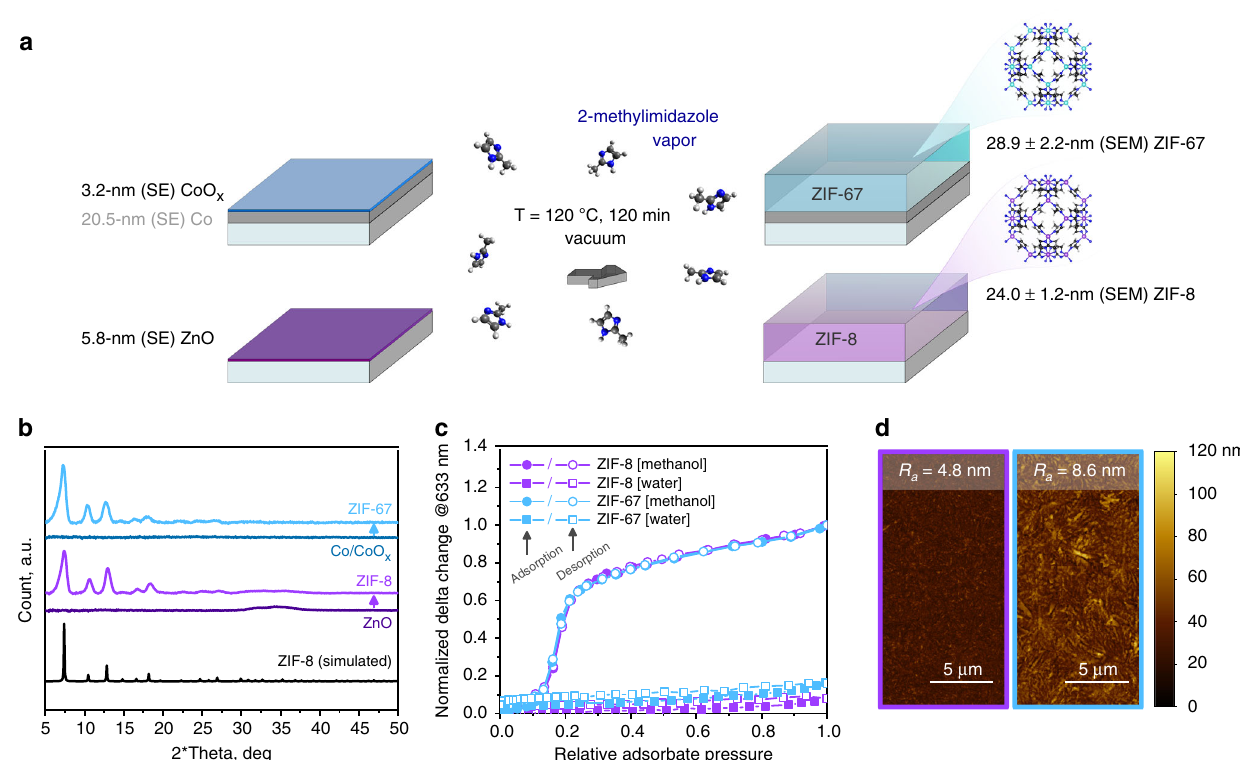
Fig. 2 Validation of the MOF-CVD process and characterization of the deposited MOF thin fi lms. a Schematic representation of the conversion of ALD ZnO and native CoO x to ZIF-8 and ZIF-67 and the corresponding increase in thickness as measured by spectroscopic ellipsometry (SE) and from SEM cross- sectional images. b Baseline-corrected GI-XRD diffraction patterns together with simulated powder diffractogram for ZIF-8. c Ellipsometric porosimetry with methanol and water as adsorbates. The amount of adsorbate corresponds to the change of the ellipsometric angle Delta (@633 nm) relative to the value recorded before introducing probe molecules. The values are normalized against the Delta change measured at methanol saturation pressure. d AFM topography images of MOF-CVD fi lms: ZIF-8 (purple frame) and ZIF-67 (light blue frame) the Zn atom areal density (30.8 × 10 15 atoms per cm 2 ) assessed by oxide crystals and (ii) the precursor-to-MOF conversion might be incomplete. Both effects were investigated for the ALD ZnO and Rutherford backscattering spectroscopy (RBS) (Supplementary native CoO x precursor layers. Fig. 4) and the thickness (8.9 nm) measured by ellipsometry. The For the ALD ZnO fi lm (45 DEZ/H 2 O cycles at 120 °C), the resulting density of Zn atoms equal to 3.45 × 10 22 atoms per cm 3 volume concentration of Zn atoms was estimated by combining is lower than that of wurtzite ZnO by ~18%, which results in the